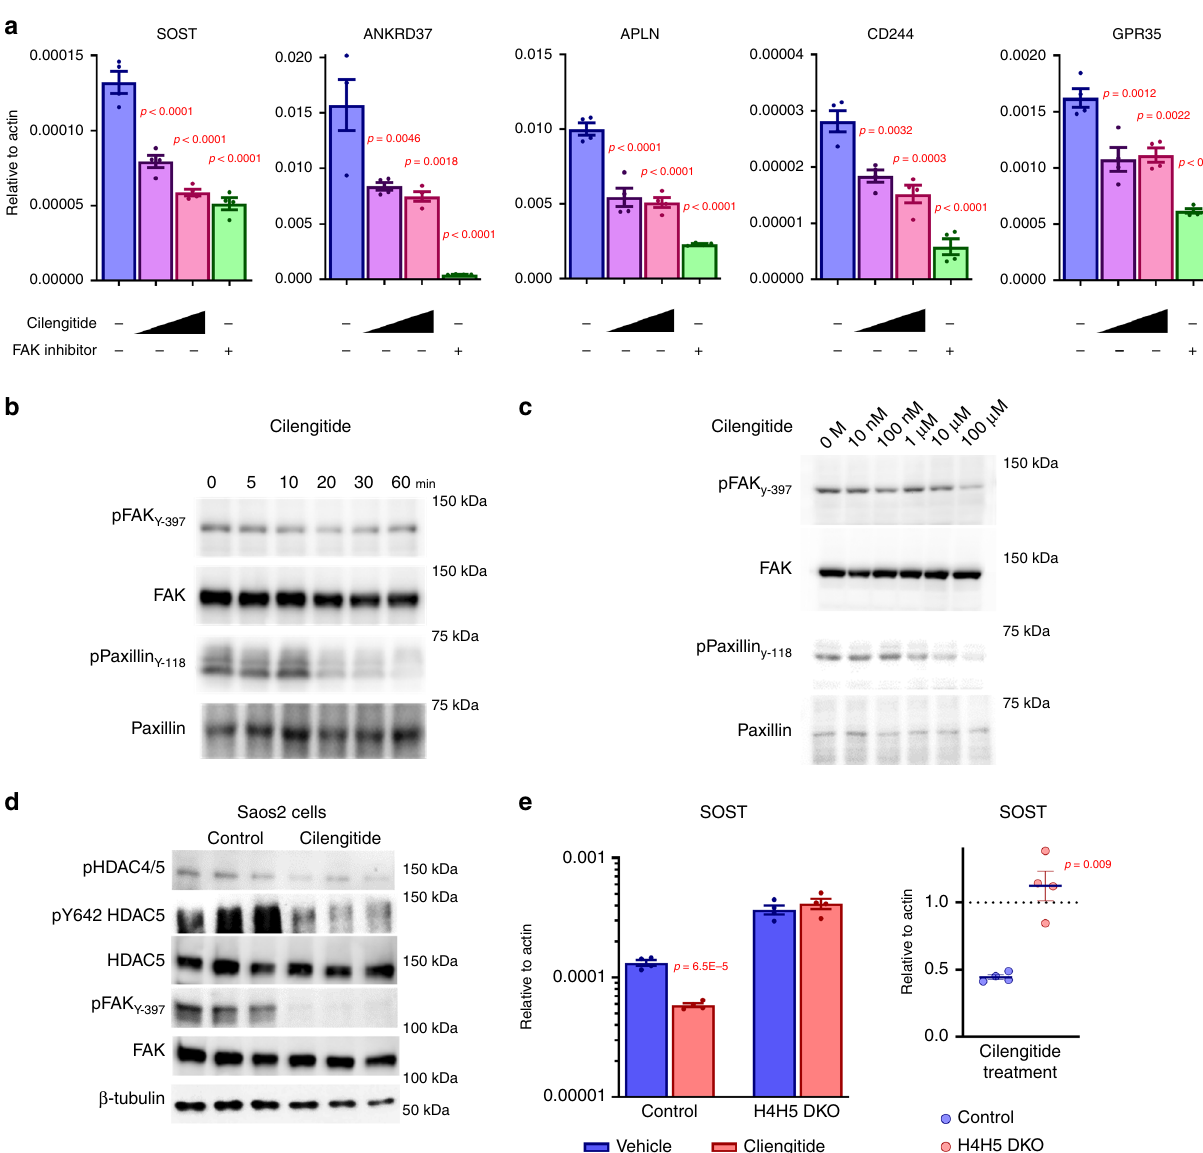
Fig. 7 RGD peptide blocks FAK activity and reduce Sost in a HDAC4/5-dependent manner. a Ocy454 cells were treated with cilengitide (10 µ M and 50 µ M) or PF562271 (10 µ M) for 4 h, followed by RT-qPCR for FFSS-regulated genes as indicated. Both cilengitide and PF562271 regulate expression of FFSS-responsive genes. ( n = 4 biologic replicates for RNA) P -values adjusted for multiple comparisons vs controls are shown. b Cells were treated with cilengitide (50 µ M) for the indicated times followed by immunoblotting. c Cells were treated with the indicated doses of cilengitide (1 h) followed by immunoblotting. pHDAC4/5 immunoblotting was performed using an antibody that recognizes HDAC4 pS246 and HDAC5 pS259. d Saos2 cells were treated with cilengitide (100 µ M) for 60 min followed by immunoblotting. e WT and HDAC4/5 double-knockout (H4H5-DKO) cells were treated with vehicle or cilengitide (50 µ M) for 4 h followed by Sost RT-qPCR. Cilengitide treatment decreased Sost expression in control cells, but not in H4H5-DKO cells. ( n = 4 biologic replicates for RNA) P -values vs control in the left and right panels. Two-sided unpaired t test e and one-way ANOVA followed by Tukey – Kramer post hoc test ( a ) were used. Data are expressed as mean ± SEM. Each experiment was repeated three times ( b – d ). Source data are provided as a Source Data fi